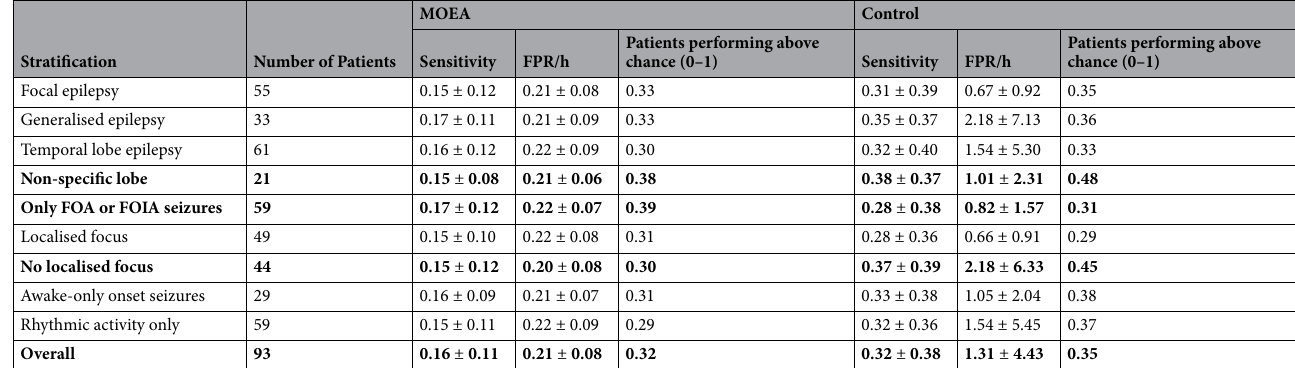
Table 1. Test results for the overall set of patients (sensitivity, FPR/h, and ratio of patients performing above chance, both for the MOEA and the control method), and for stratified sets of patients. Stratification concerned patients the following criteria: (i) focal epilepsy patients (seizure focus in only one hemisphere), (ii) generalised epilepsy patients (seizure focus in more than on hemisphere), (iii) temporal lobe epilepsy patients (seizure focus only in temporal lobe), (iv) patients whose seizure focus is not lobe-specific, (v) patients suffering only from FOA/FOIA seizures, (vi) patients whose surgery was offered (localised focus), (vii) patients whose surgery was not offered (not localised focus), (viii) patients that only experienced seizures while they were awake., and (ix) patients with pre-seizure activity annotated as rhythmic by clinicians. The overall results and the best performing stratified groups are in